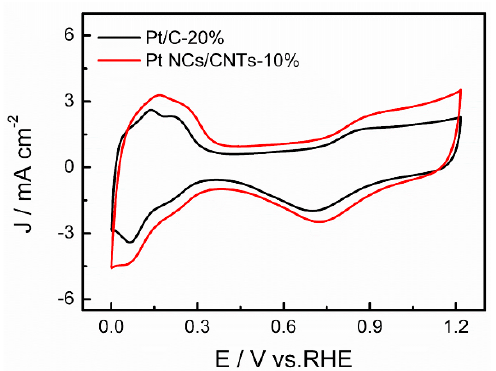
Figure 5. Cyclic voltammograms (CVs) of Pt NCs/CNTs-10% and Pt/C-20% in Ar-saturated 0.1 M HClO 4 at 50 mV s − 1 .